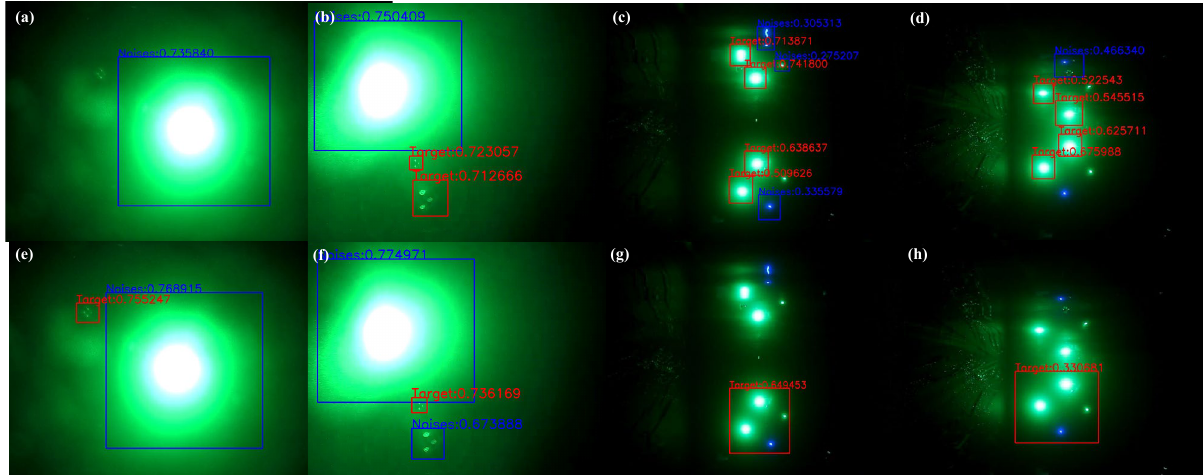
Figure 11. Target detection result: ( a – d ) are YOLO V5n detection results; ( e – h ) are YOLO V5_CA detection results.